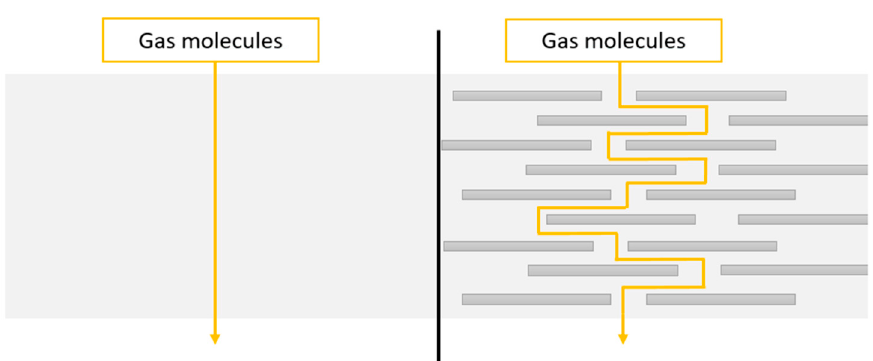
Figure 7. A scheme of a tortuous pathway in a polymer matrix without (left side) and with exfoliated nanoplatelets (right side) [109.